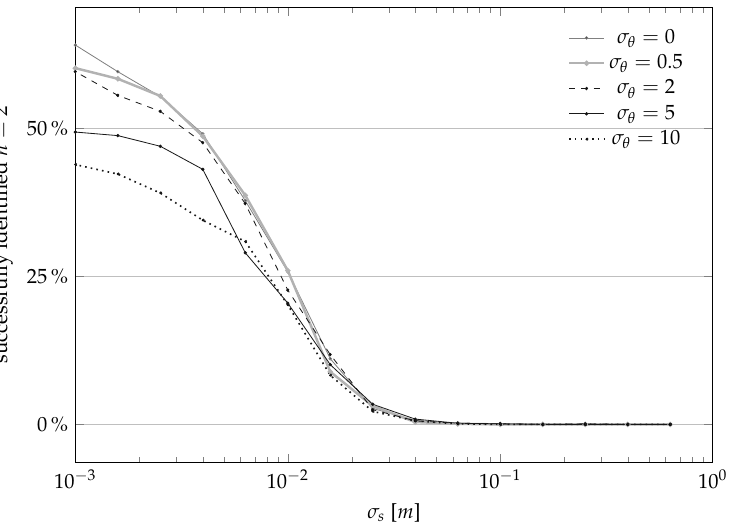
Figure 9. Dependency of the MSE ratio (31) on the standard deviation σ θ of the sensor-to-landmark angle measurement error in (6), and on the standard deviation σ s of the sensor position evolution uncertainty in (8) for the case L = 2.